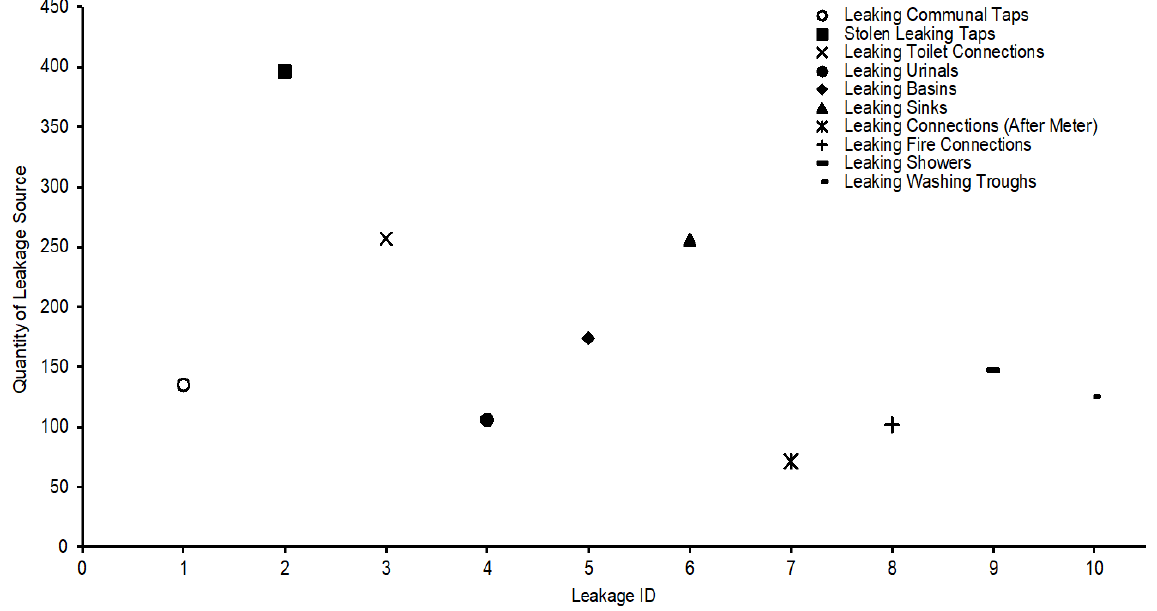
Figure 2. The socio-domestic and background leakage sources from households.